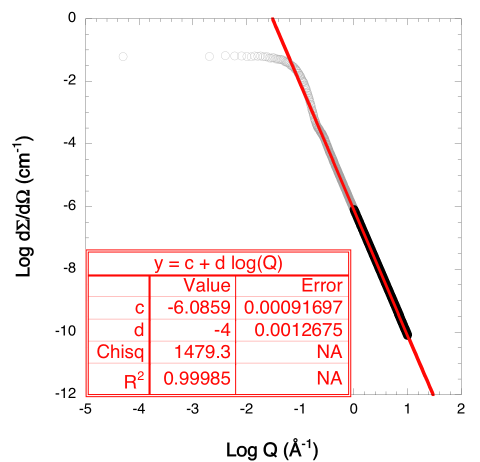
Figure 4. Porod approximation of the simulated SCS by using the SDF with σ = 0.2. The points used for the fit are shown with black symbols, while the others are red. The fit is shown with a red line. From the optimized parameters of the linear interpolations and their estimated errors, it is possible to calculate the physical quantities needed to apply the SPA, i.e., d